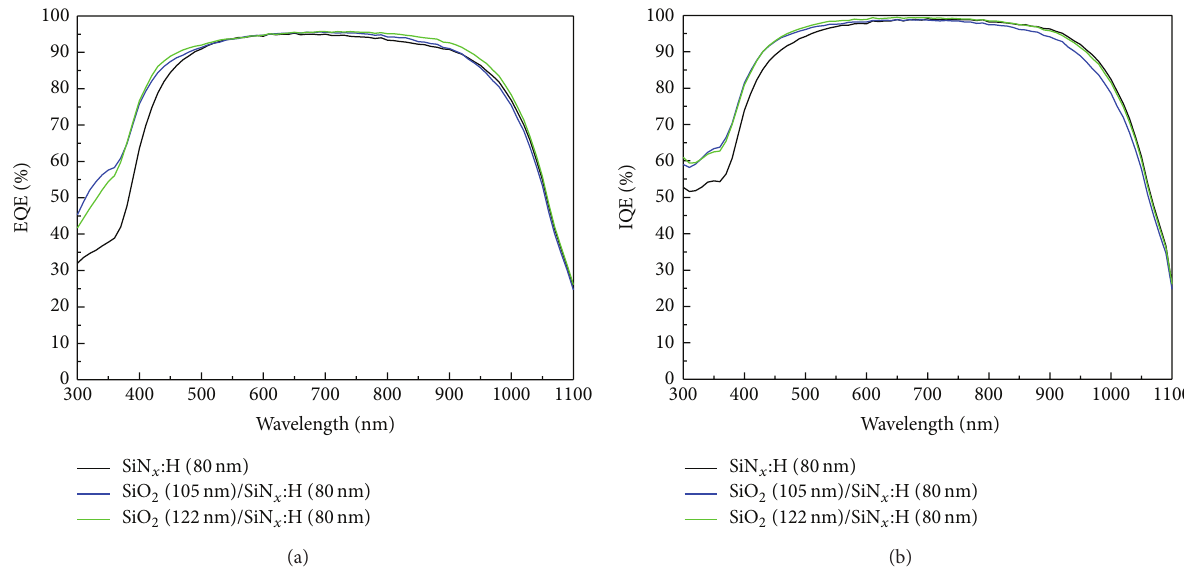
Figure 5: EQE and IQE of the single layer ARC and double layer ARC solar cells.